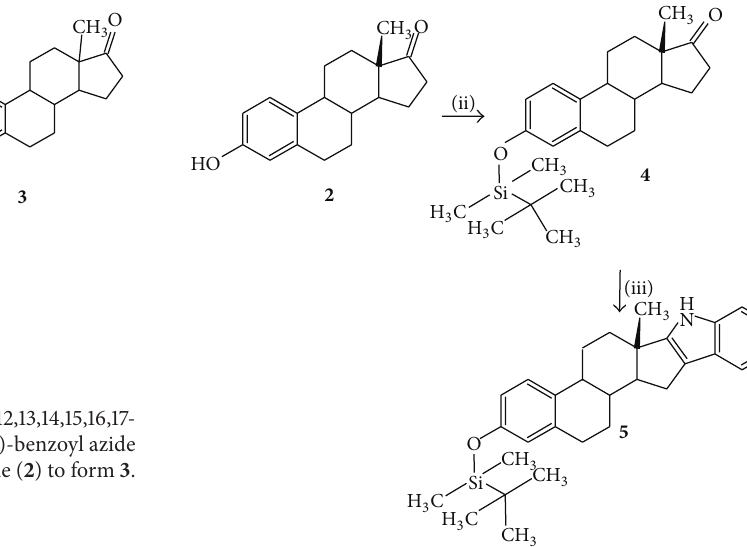
Figure 2: Synthesis of 3-(tert-butyl-dimethyl-silanyloxy)-NH- indolo[2 󸀠 3 󸀠 :17,16]estra-1,3,5(10)-triene ( 5 ). The first stage involves protection of hydroxyl group from estrone ( 2 ) with tert- butyldimethylsilyl chloride (ii) to form the compound 4 (3-(tert- butyl-dimethyl-silanyloxy)-13-methyl-6,7,8,9,11,12,13,14,15,16-deca- hydro-cyclopenta[a]phenanthren-17-one). In the following stage, 4 was made reacting with phenylhydrazine hydrochloride to the synthesis of 5 . (iii) = and acetic